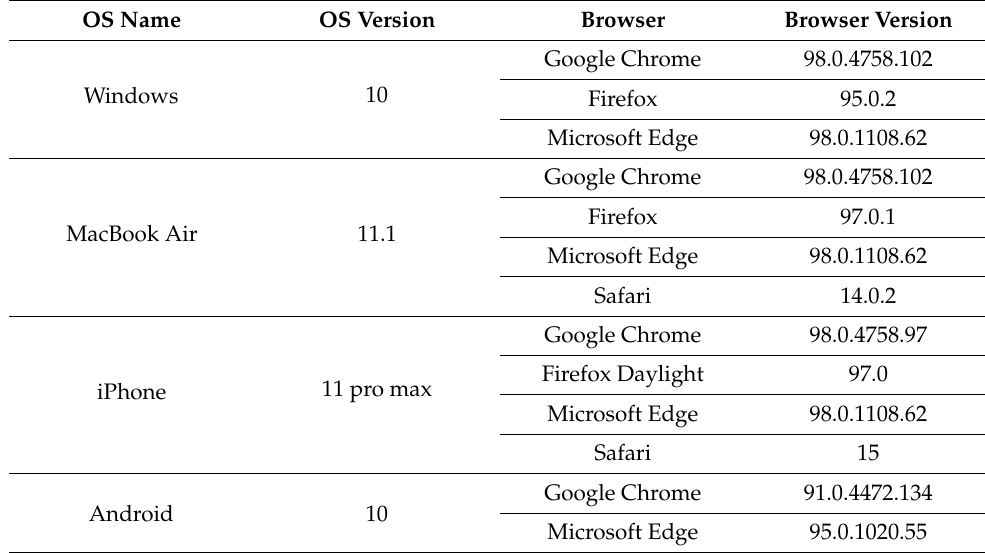
Table 2. The characteristics of the devices and web applications.